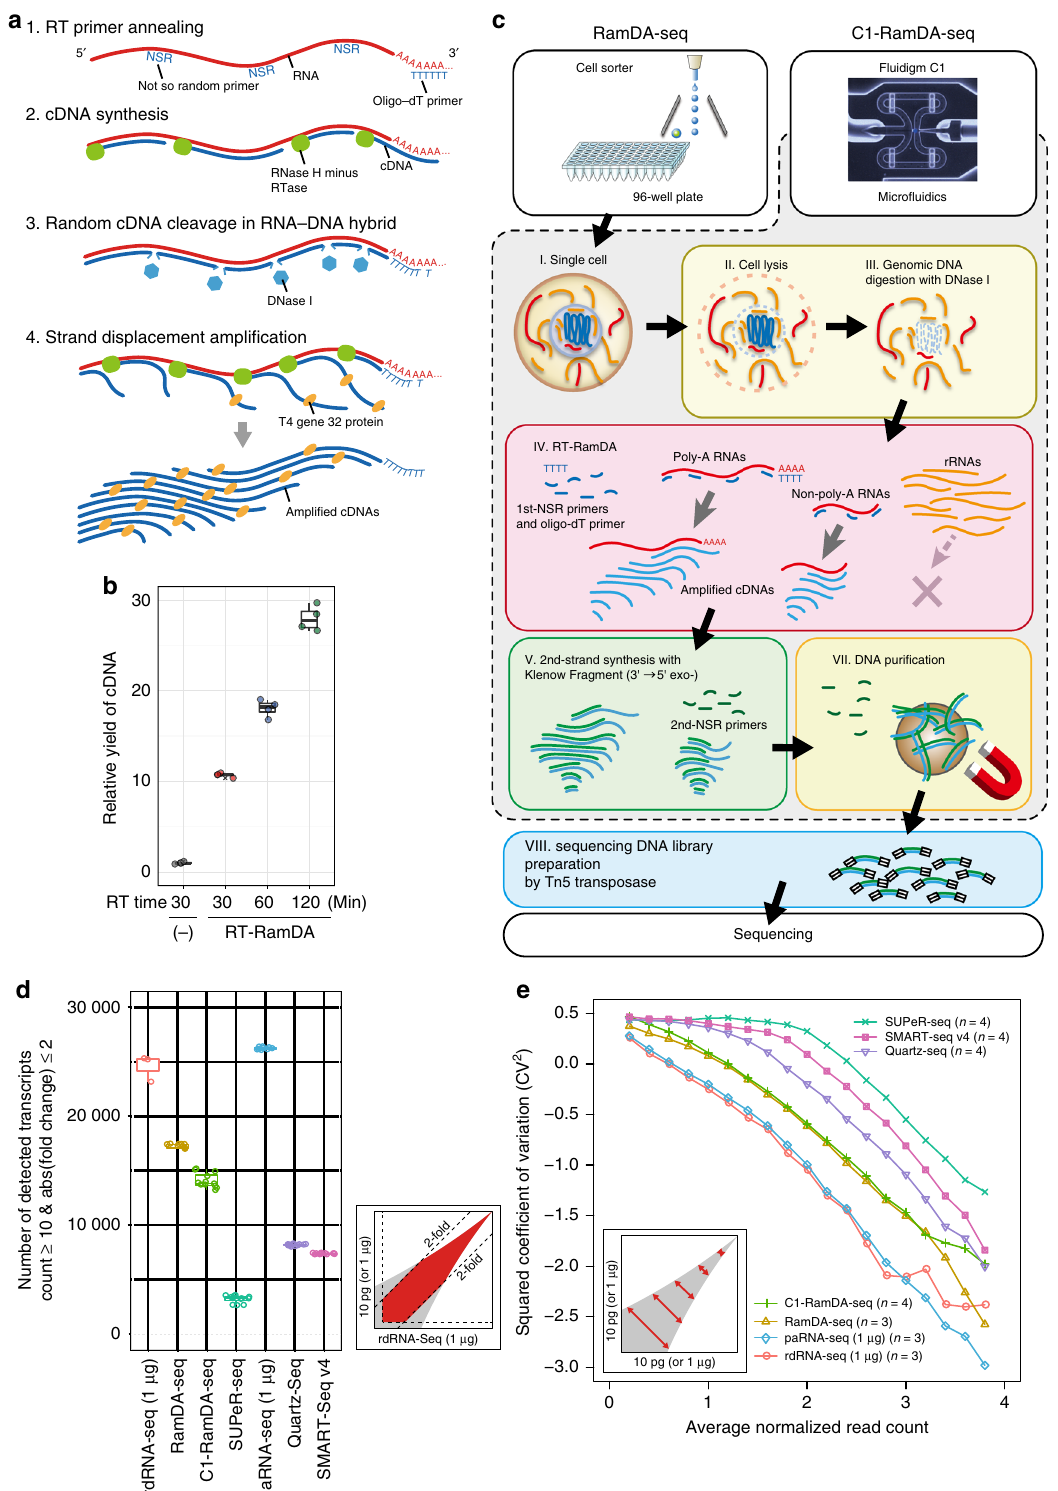
V. 2nd-strand synthesis with Klenow Fragment (3' 5'